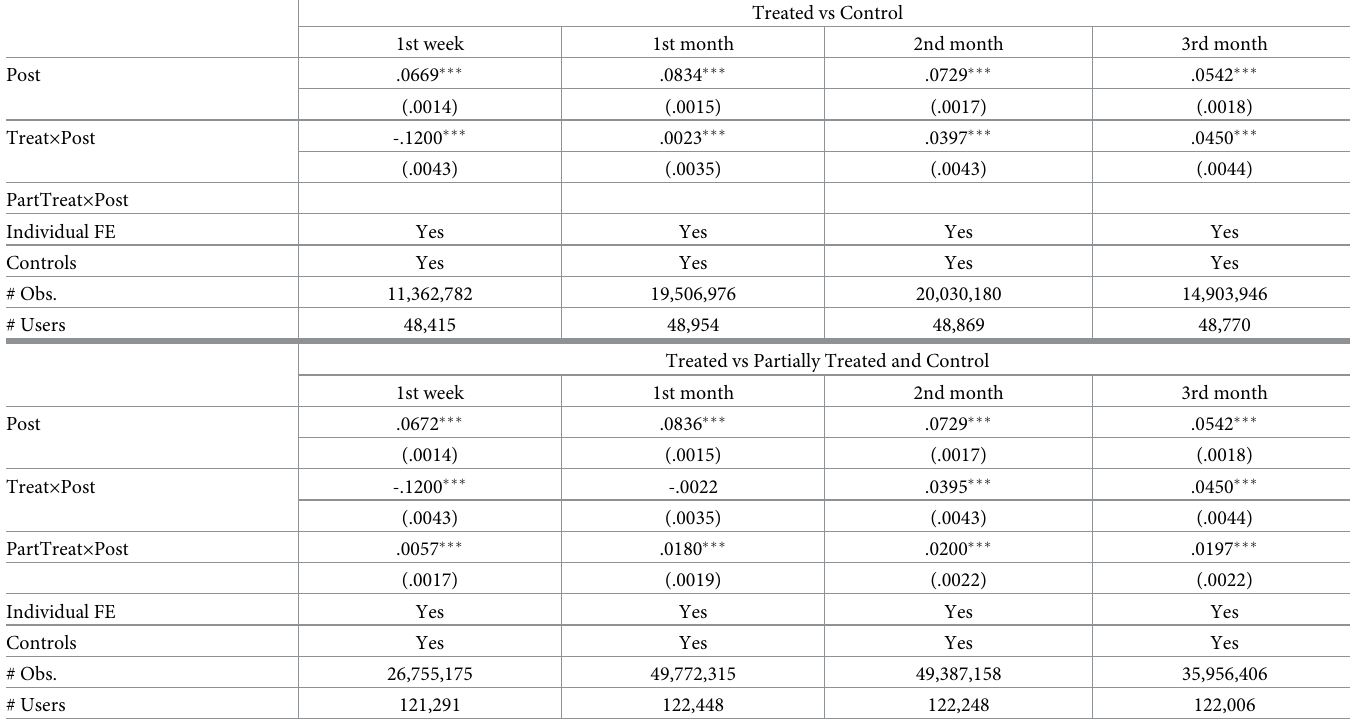
Table 3. Dynamics of the shift in family